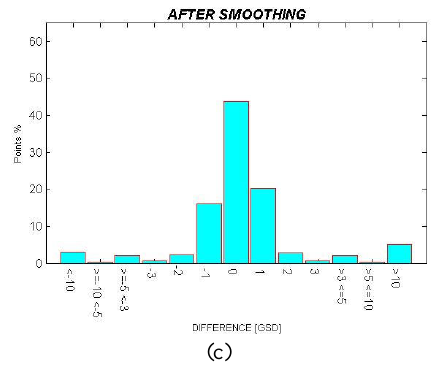
Figure 5: denoised DSM (a), differences between ground truth and the smoothed DSM using the bilateral filter (b) and histogram of the differences (c).